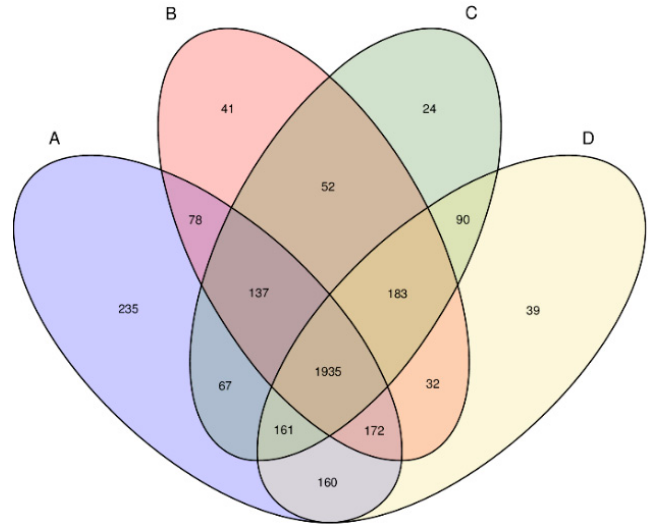
Figure 3. Overlap of the bacterial communities from four sludge samples based on OTU (3% dis- tance). Note: A: inlet; B: aerobic zone; C: anoxic zone; D: anaerobic zone. Note: A: raw wastewater; B: aerobic pool; C: anaerobic pool; D: anaerobic fermenter.